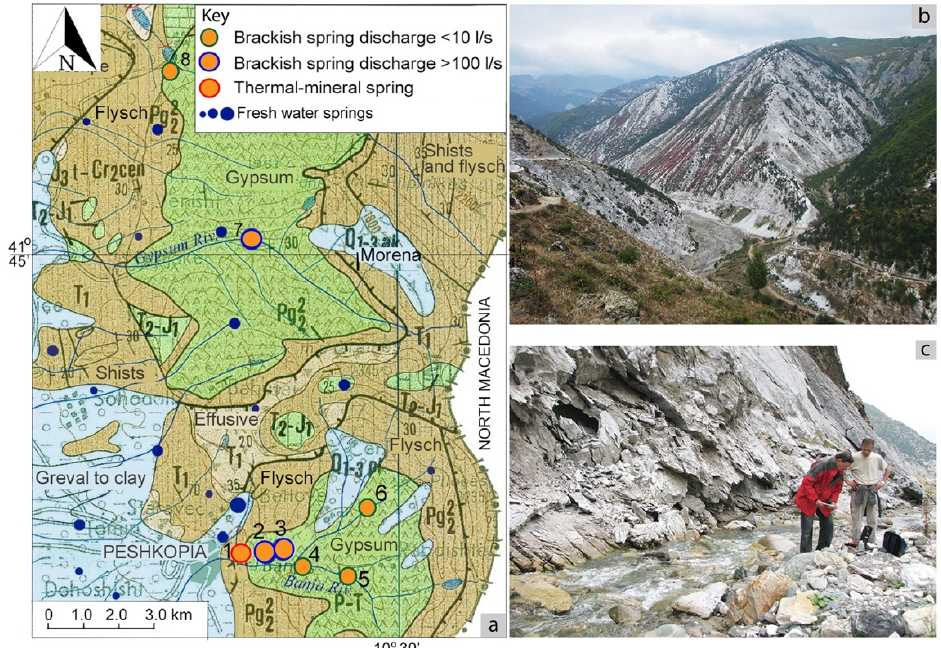
Figure 2. ( a ) Hydrogeological map of the Peshkopi area at Korab (modified after [33]) with the locations of springs: 1, Banya (thermal spring); 2, Brezhdani; 3, Konri; 4, Gypsum; 5, Rabdishta; 6, Bellova; 7, Gypsum River; and 8, Vlesha; ( b ) Gypsum River; ( c ) field hydro-chemical measurements in Gypsum River.